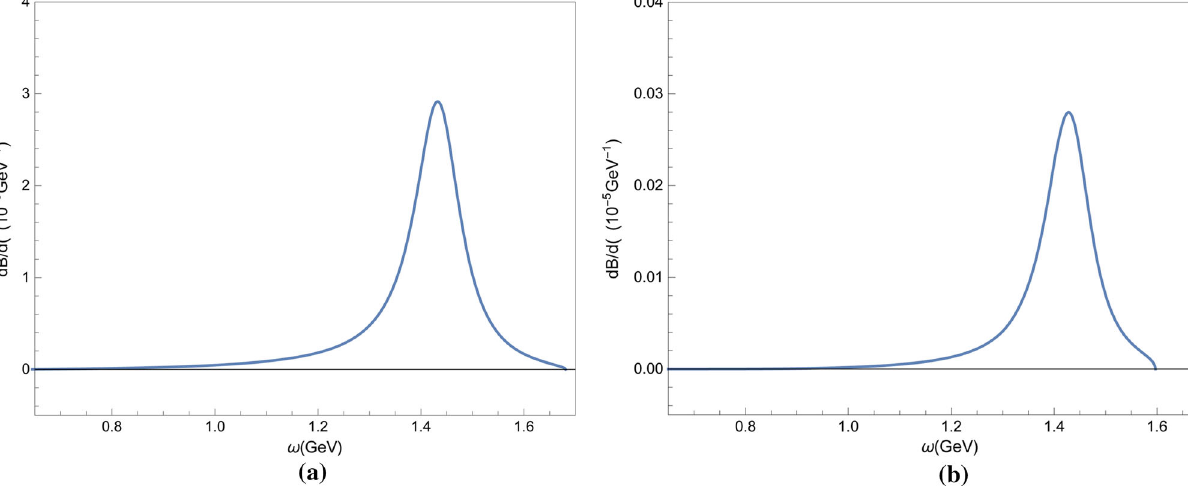
Fig. 4 Differential branching ratios of the D-wave for a B 0 s → ψ( 2 S ) K − π + and b B 0 s → ψ( 1 D ) K − π